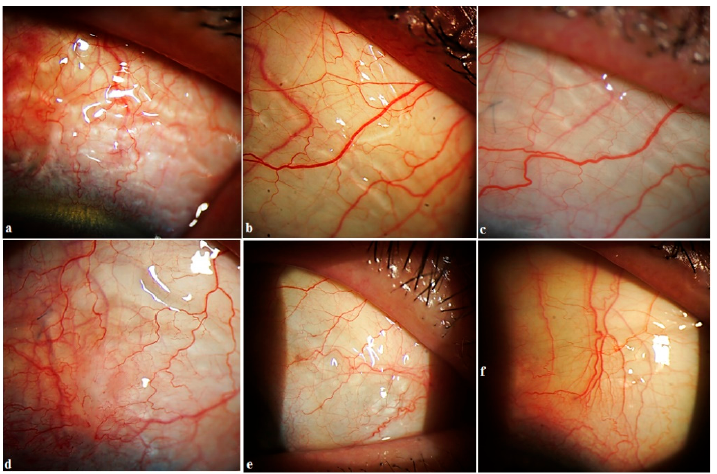
Figure 7. Showing different patterns of lymphatic vessels. ( a,b,d,e ) Lymphatics in the form of plexus. ( c ) Radially running vessels. ( f ) A case with few vessels.